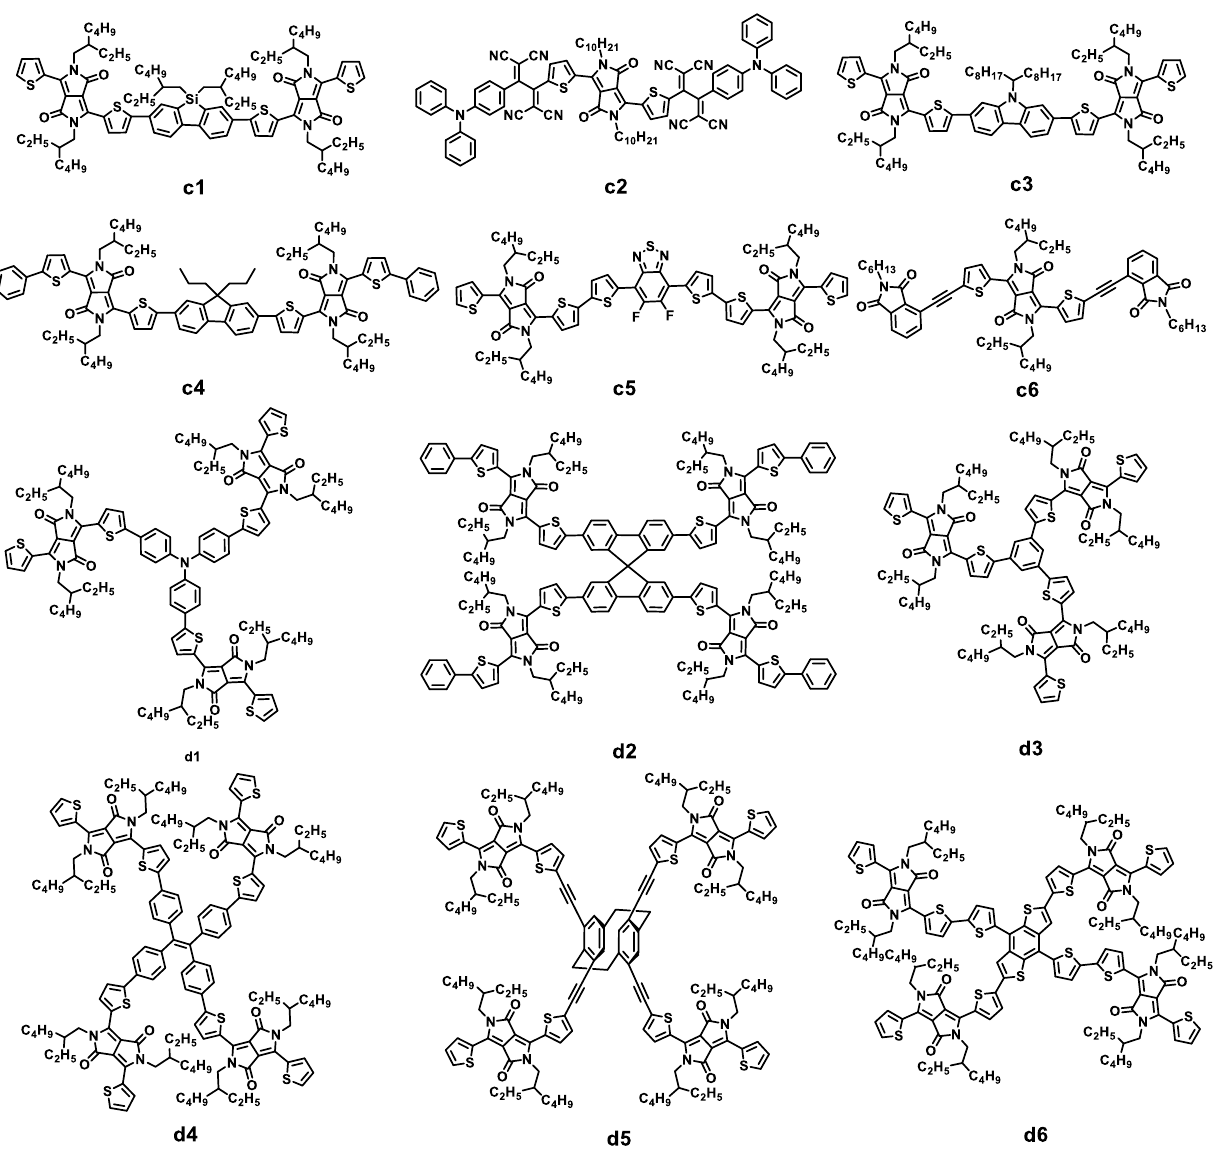
Fig. 3 Chemical structures of DPP based